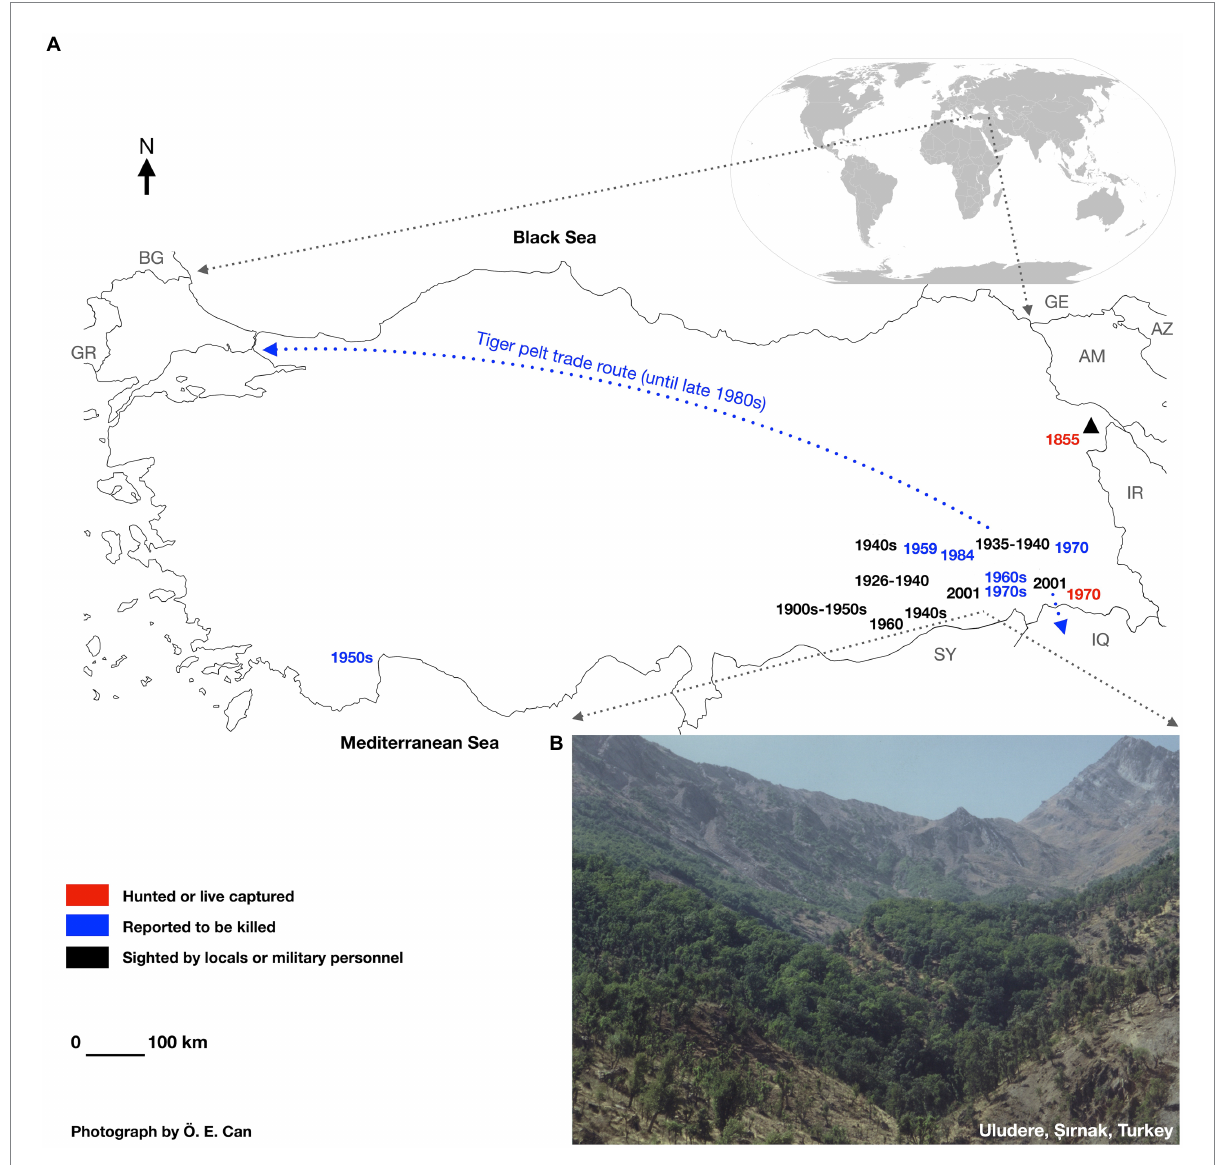
FIGURE 1 (A) Caspian tiger records for the period between 1855 and 2001 in Turkey (a tiger reported to be hunted by Enver Pașa (1882–1922) in Eastern Turkey is not shown as exact location of the hunt is unknown). (B) A view from Caspian tiger habitat, Uludere district, Turkey where a male tiger was killed in 1970 and another was one reported at 3000 meters in 2001. The region is still a stronghold of tiger prey species. The black triangle figure on map represents Ağrı Mountain (5,137 meters). The abbreviations used in the map are as follows; GR, Greece; BG, Bulgaria; GE, Georgia; AZ, Azerbaijan; AM, Armenia; IR, Iran; IQ, Iraq; SY, Syria. The world map from Wikimedia Commons is under Creative Commons CC0 1.0 Universal Public Domain. Map of Turkey was created with